Question: Draft a figure caption describing what is shown.
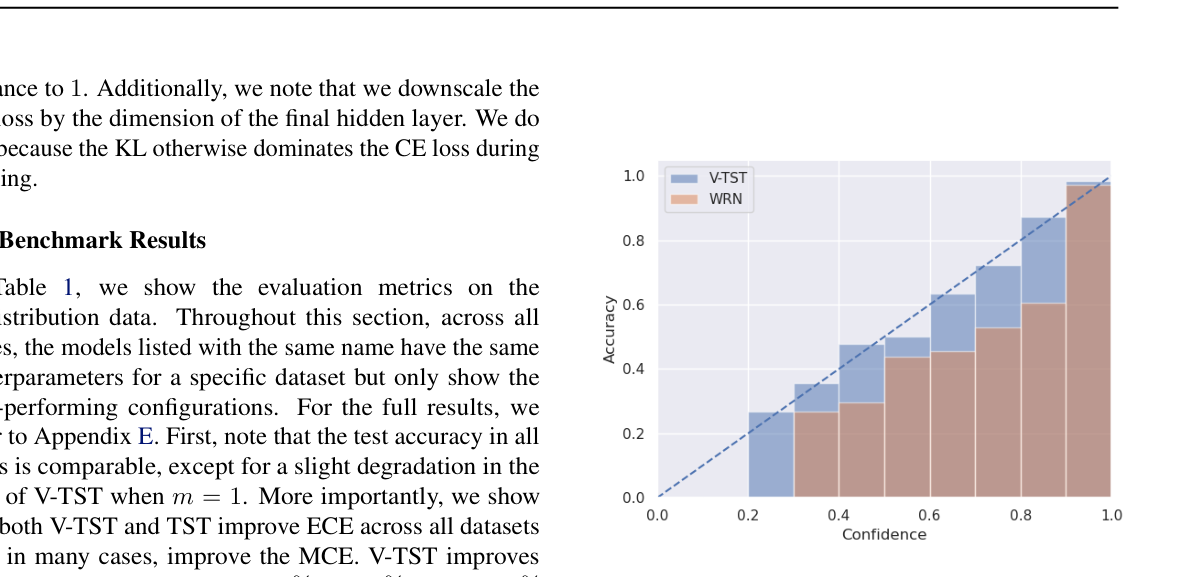
Answer: ECE plot of V-TST trained model and base WRN trained on SVHN.